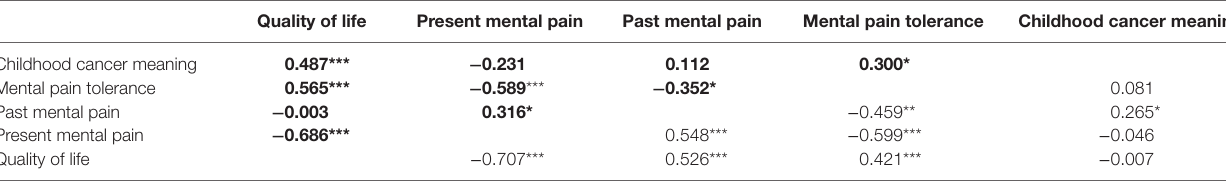
TaBle 3 | Pearson correlation coefficients between groups by dependent variables.